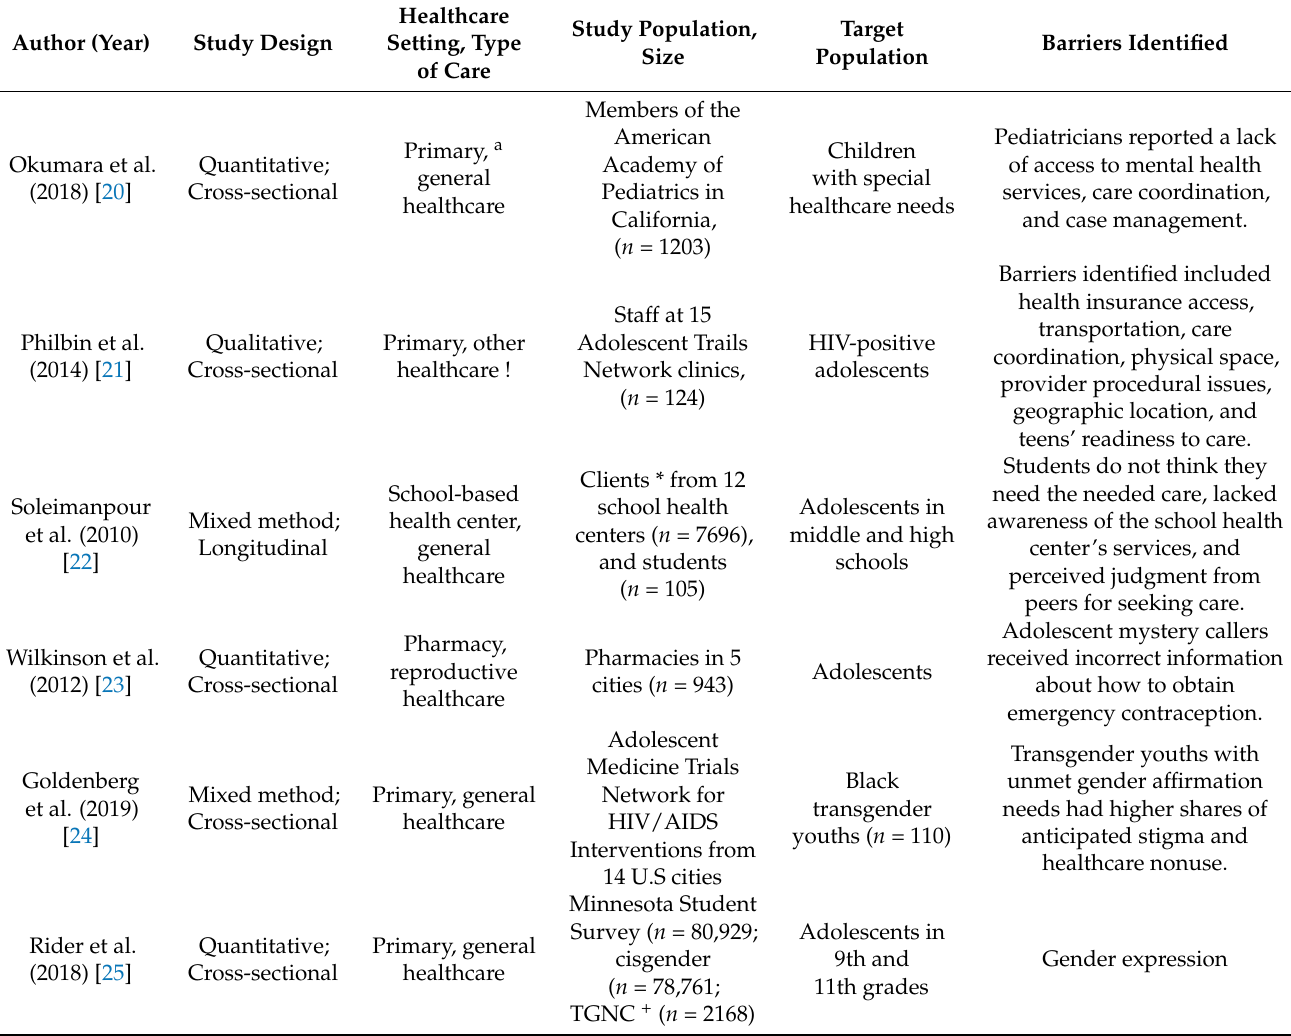
Table 1. Characteristics of Included Articles for Scoping